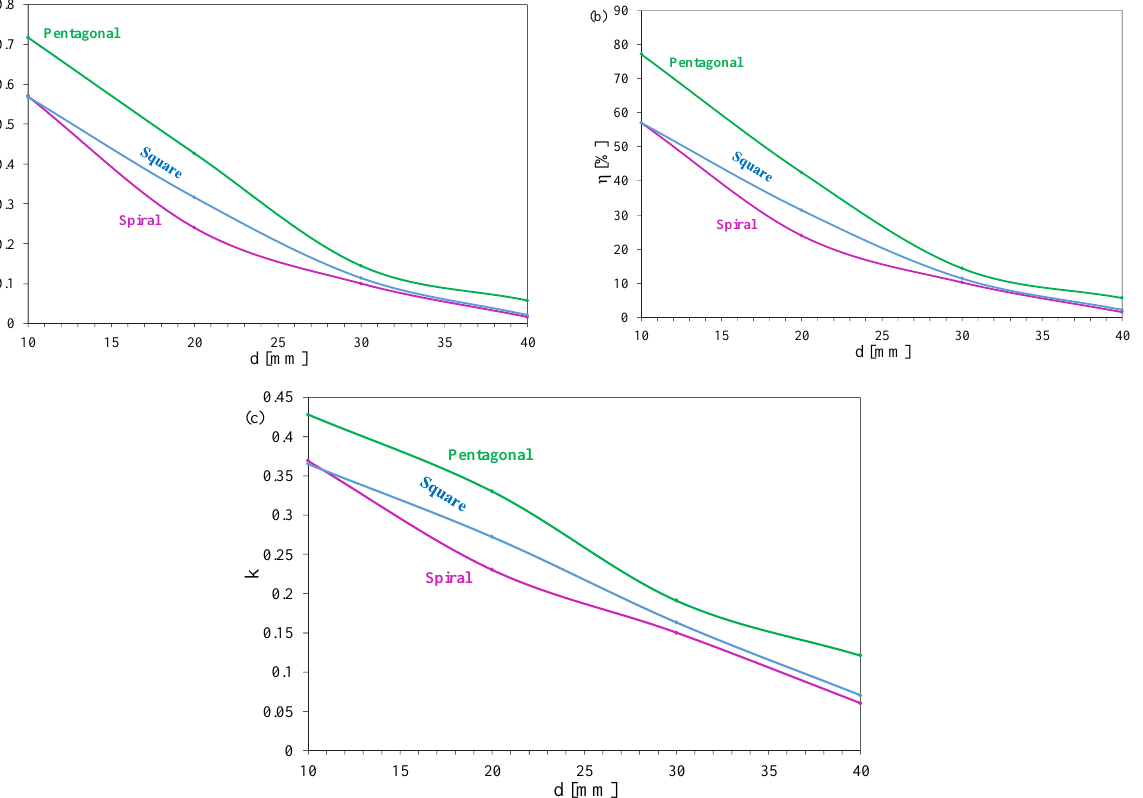
Figure 7. Dependence of the output power ( a ), energy transmission efficiency ( b ), and coupling coefficient ( c ) on the distances between the coils of different shapes.